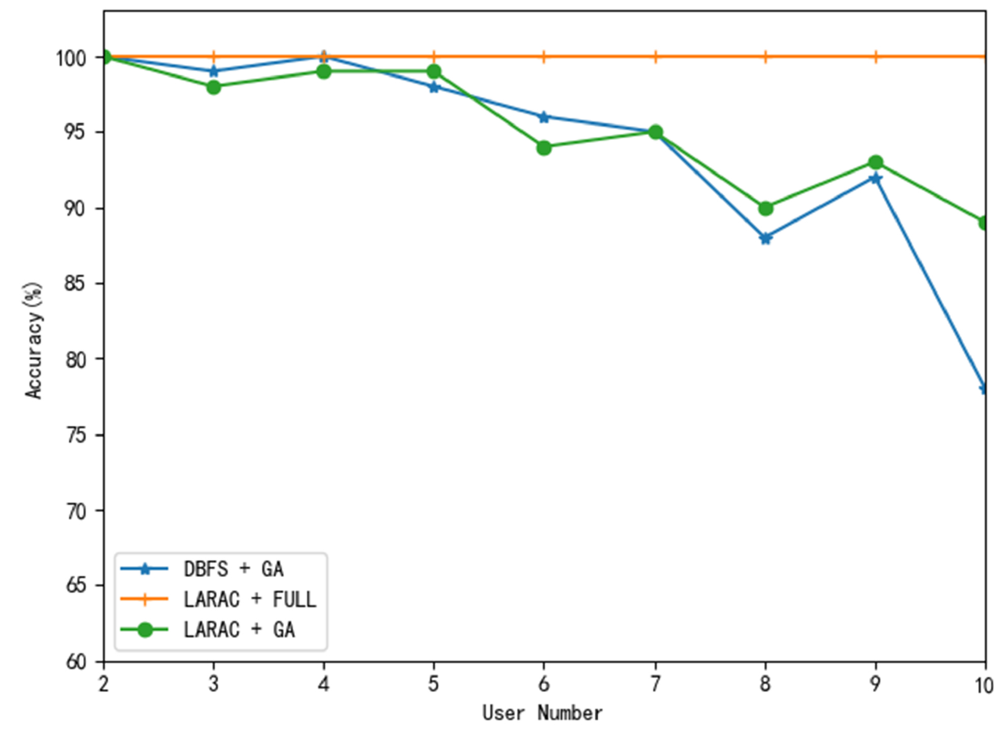
Figure 4. User number vs.